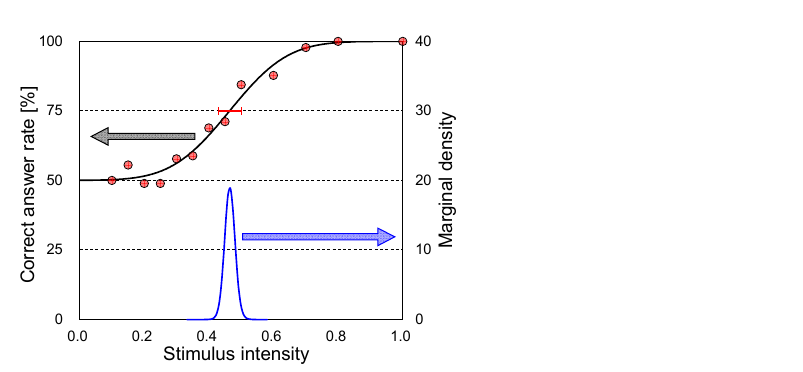
Figure 7. The estimated psychometric function with the parameters and the posterior distribution of the threshold.